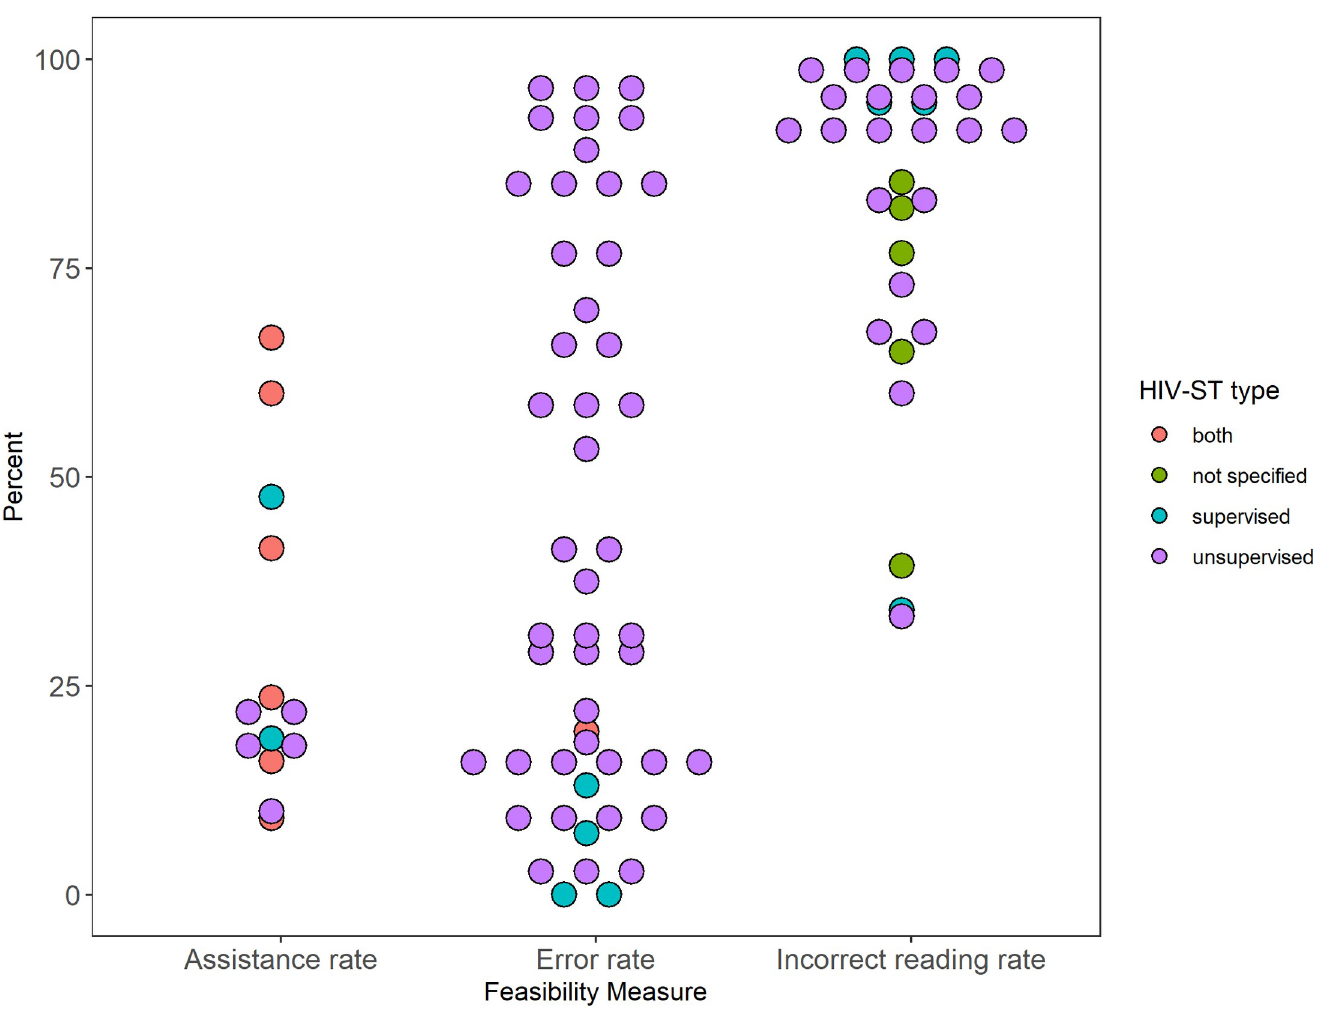
Fig 5. Feasibility